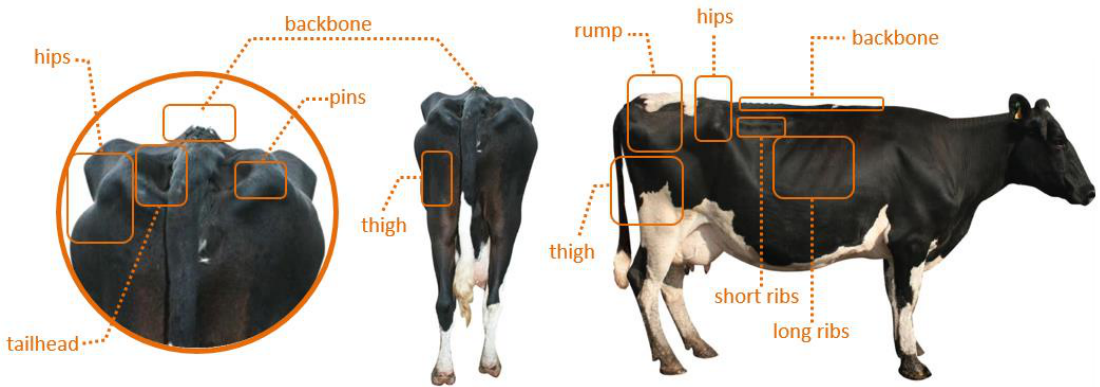
Figure 1. Key areas of cow body for Body condition scores (BCS) assessing. The left half shows the back view of the cow. The right half shows the side view of cow.